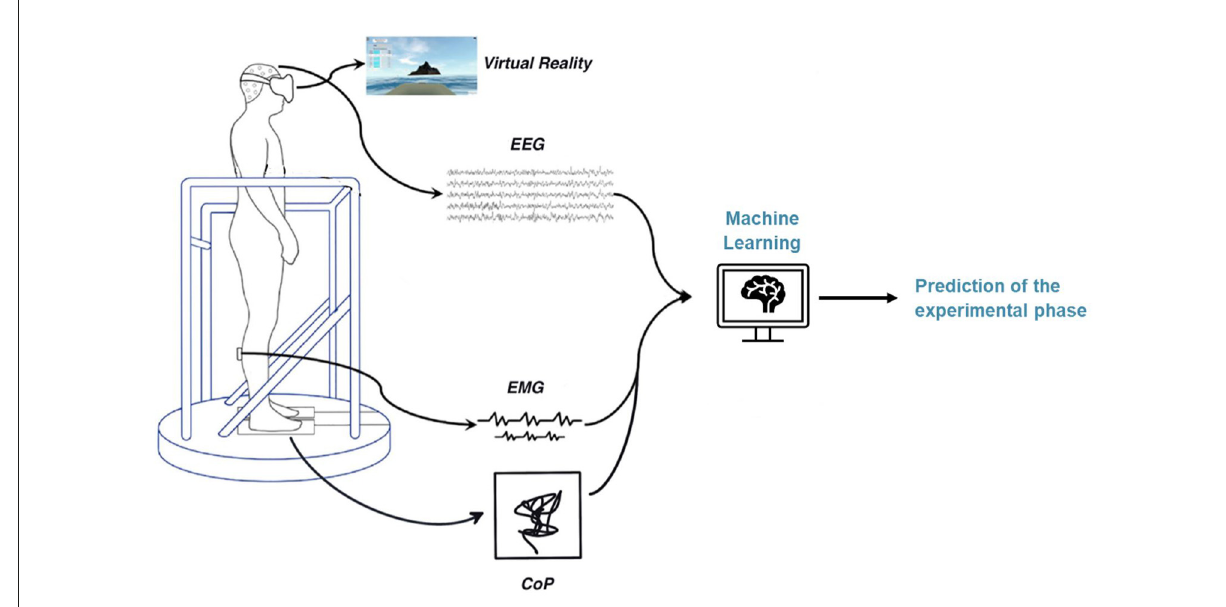
FIGURE1 BioVRSea measurement